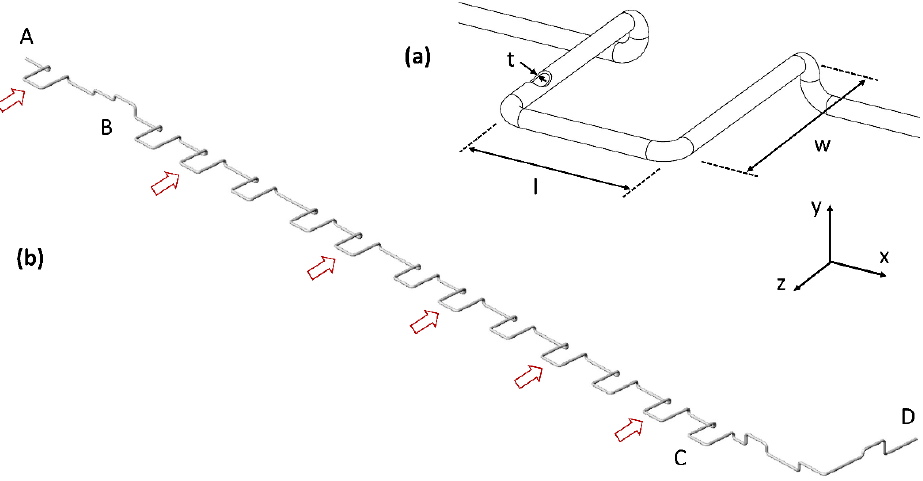
Figure 1. Pipeline system: ( a ) expansion loop; ( b ) part of line analyzed.